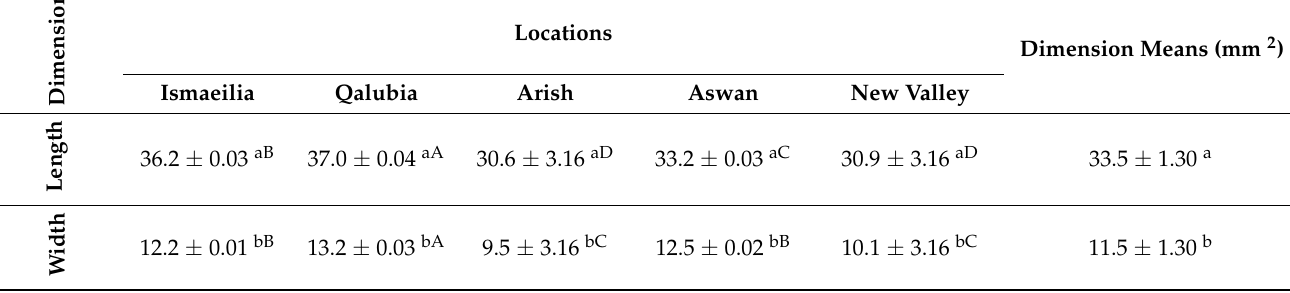
Table 1. Measurements (mean ± SE mm) of body (length and width) of RPW adults brought from five different geographic Egyptian locations during 2019.